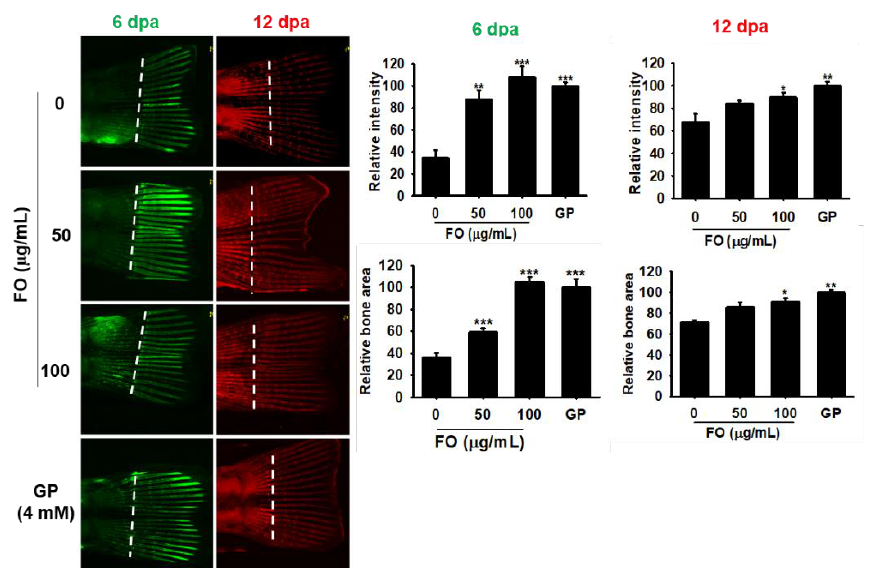
Figure 6. FO promotes caudal fin regeneration in adult zebrafish. Adult zebrafish ( n = 15) were immersed in FO for 12 days post amputation (dpa). Next, fish caudal fins were subjected to double fluorochrome labeling with calcein and alizarin red at 6 and 12 dpa, respectively. Bone regions labeled with calcein (green) and alizarin red (red) indicate new bone regeneration at 6 and 12 dpa. Relative intensity of each bone vein was calculated using the Image J software. Amputation axis is also indicated (dashed line). Significant differences among the groups were determined using the one-way ANOVA followed by Bonferroni correction. All data are presented as mean ± SEM (*** p < 0.001, ** p < 0.01, and * p < 0.05 versus untreated group). FO; fermented extract of C. gigas and GP; β-glycerophosphate.